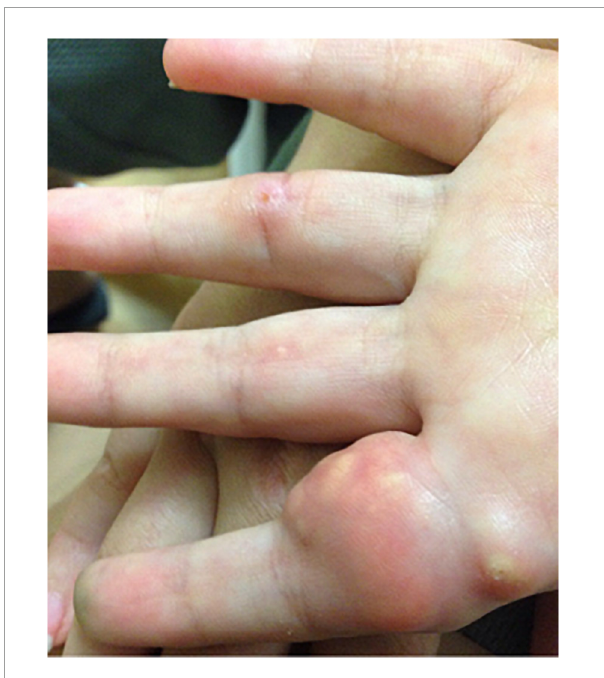
FIGURE1 Photograph of calcinosis lesions of the fingers of a child with juvenile dermatomyositis. Permission obtained from the patient for publication of this image.